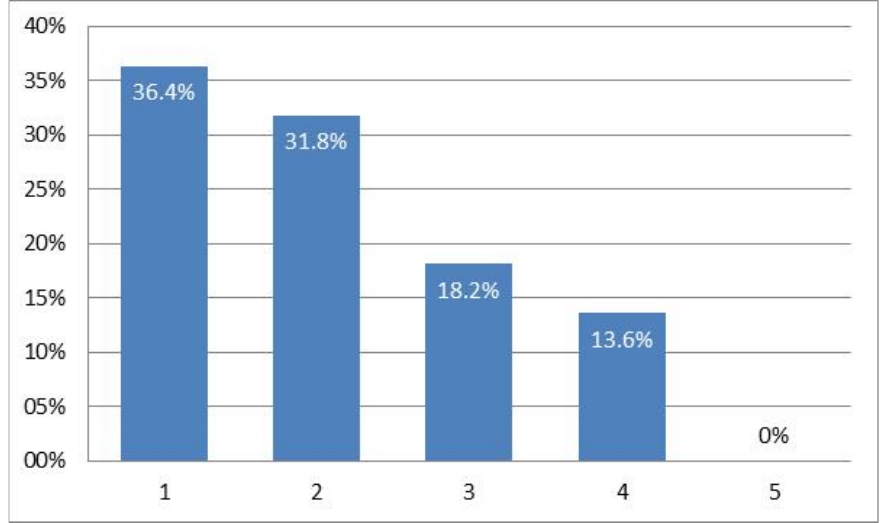
Figure 4. Degree of physical or corporal affectation.